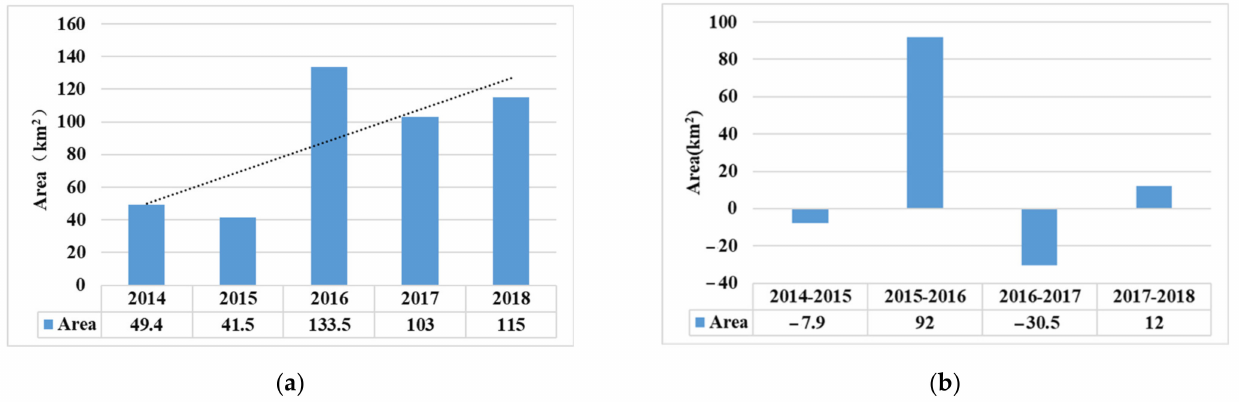
Figure 12. Statistical results of raft extraction in Sansha Bay from 2014 to 2018. ( a ) Area of raft culture in Sansha Bay from 2014 to 2018. ( b ) Change in area of raft culture during